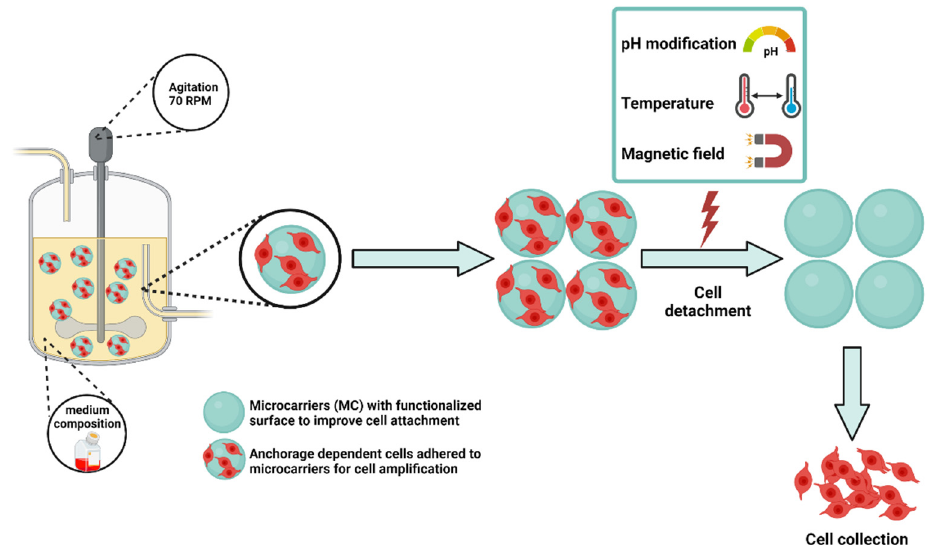
Figure 5. Culture system for scalable growth and controlled differentiation of stem cells using surface functionalized microcarriers (MC) to promote cell attachment. MC have stimuli responsive properties which can be used to trigger cell detachment, improving thereby the cells harvesting. Created by BioRender.com (accessed on 23 rd February 2022). Table 3. Recent examples of polymeric microparticles used for cell expansion.